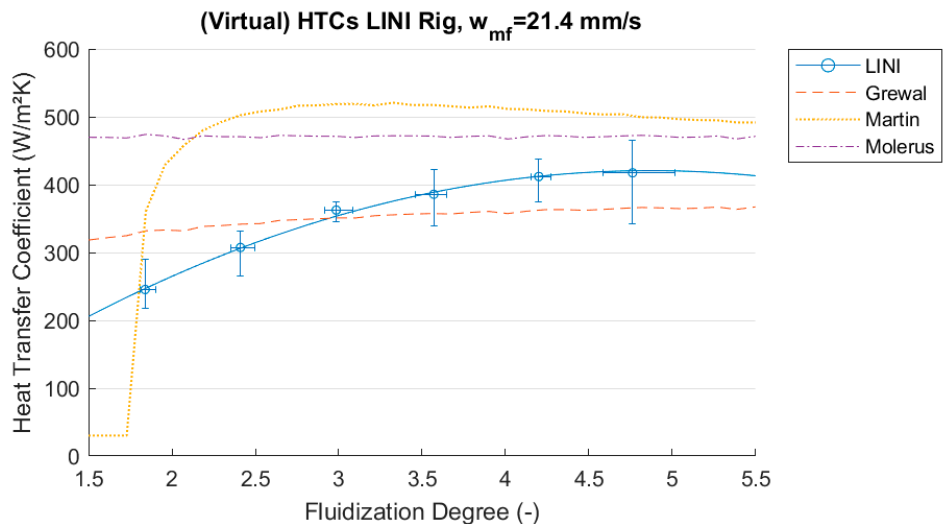
Figure 22. Comparison of LINI results, 146 µ m particles.